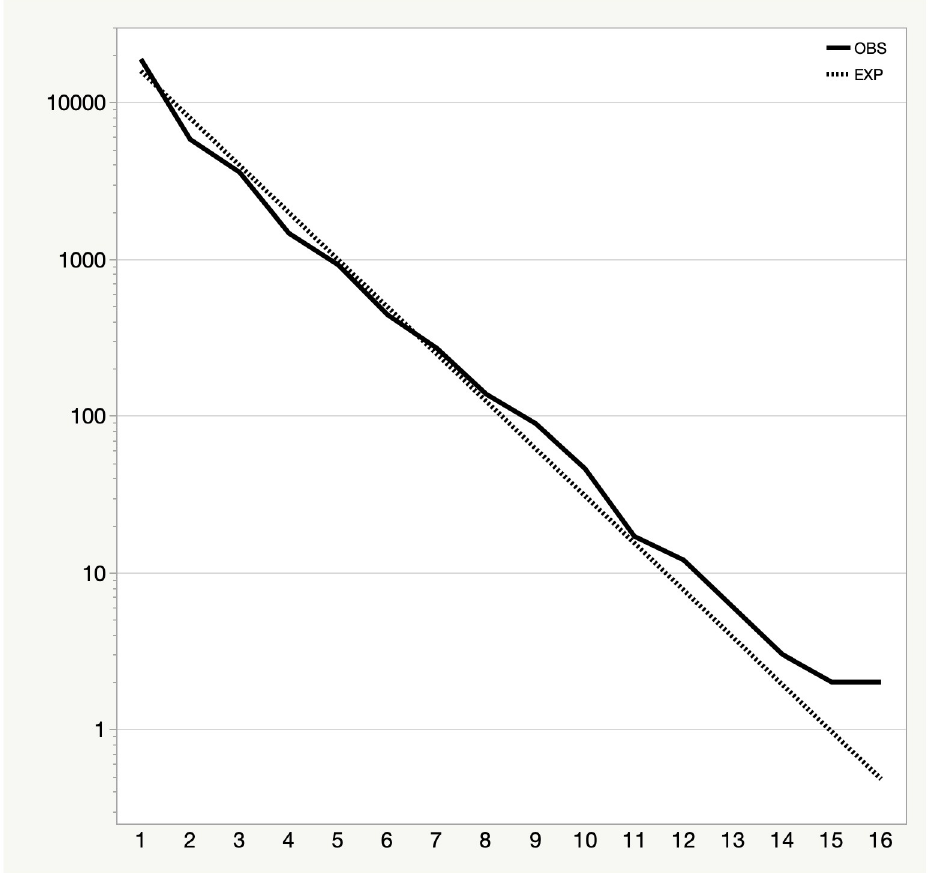
Fig 3. Observed (solid) and expected (dotted) occurrences of runs of a given length (ranging from 1 to 16). Note the logarithmic scale for occurrences.